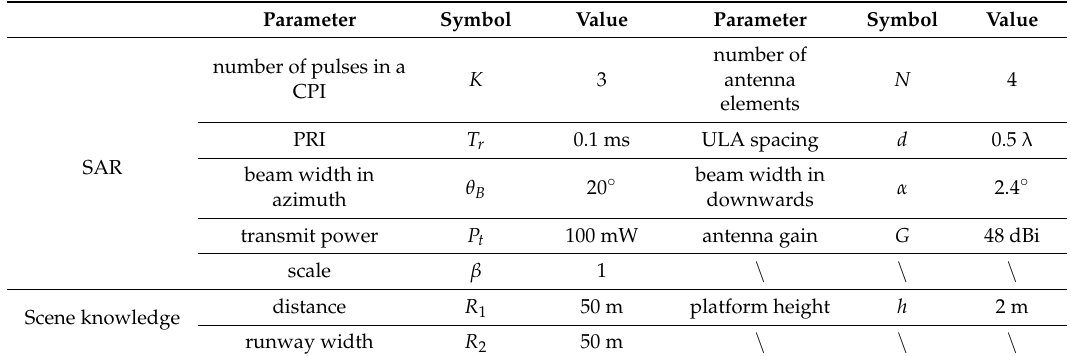
Table 3. Parameter setting of simulations.